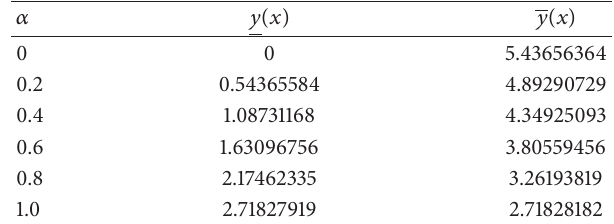
Table 2: Approximate solution.